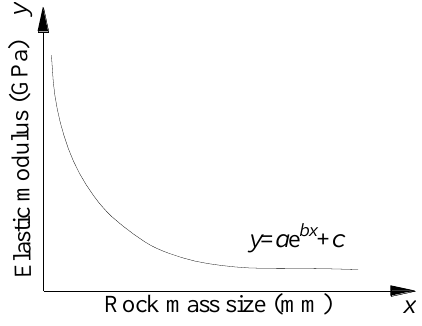
Rock mass size (mm) Figure 6. The correlation between rock mass size and elastic modulus Figure 6. The correlation between rock mass size and elastic modulus [33].